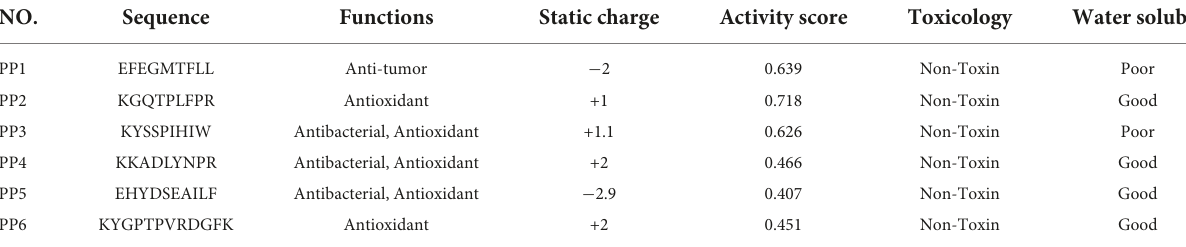
TABLE 1 The biological activity, water solubility, toxicity and their functions of